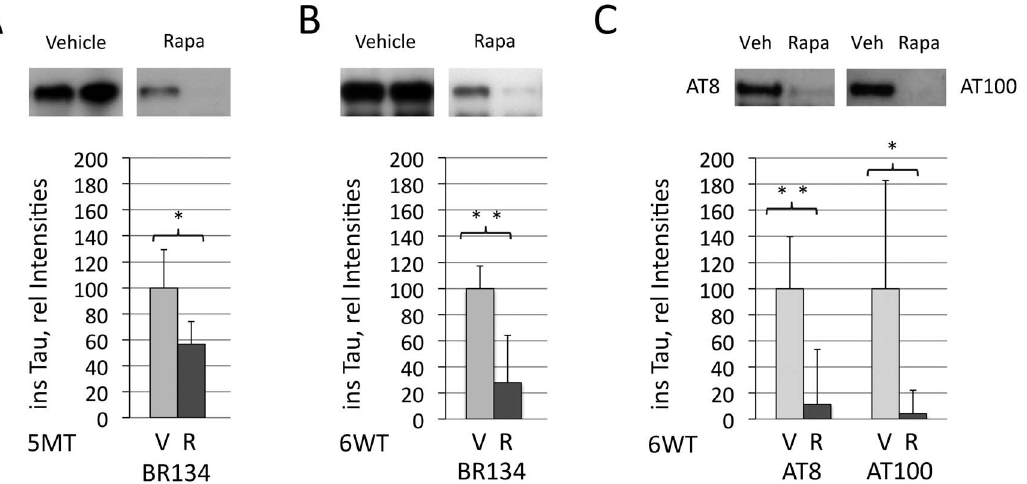
Figure 3. Levels of sarkosyl extracted insoluble tau were significantly reduced in the forebrain of P301S mice after 5 months of long-term rapamycin treatment (R, n=6) when compared to vehicle treated mice (V, n=5) (A, 5MT group; Western blot using BR134 antibody). A comparable lowering of insoluble tau was obtained by late short-term rapamycin administration over 6 weeks (B; 6WT group, n=6/6). In parallel, the accumulation of tau hyperphosphorylated at the AT8 and AT100 epitopes was significantly lowered (C; 6WT group, n=6/6). Quantification of tau Western blots was subjected to unpaired T-tests and T-tests adjusted for unequal variances (Welch-Test), yielding both similar results. * p , 0.05 and ** p ,